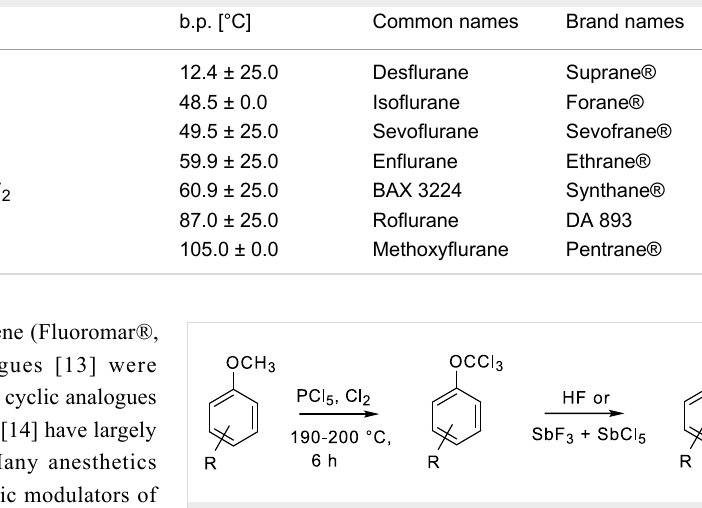
Table 1: α-Fluorinated ethers used as Anesthetics. Entry